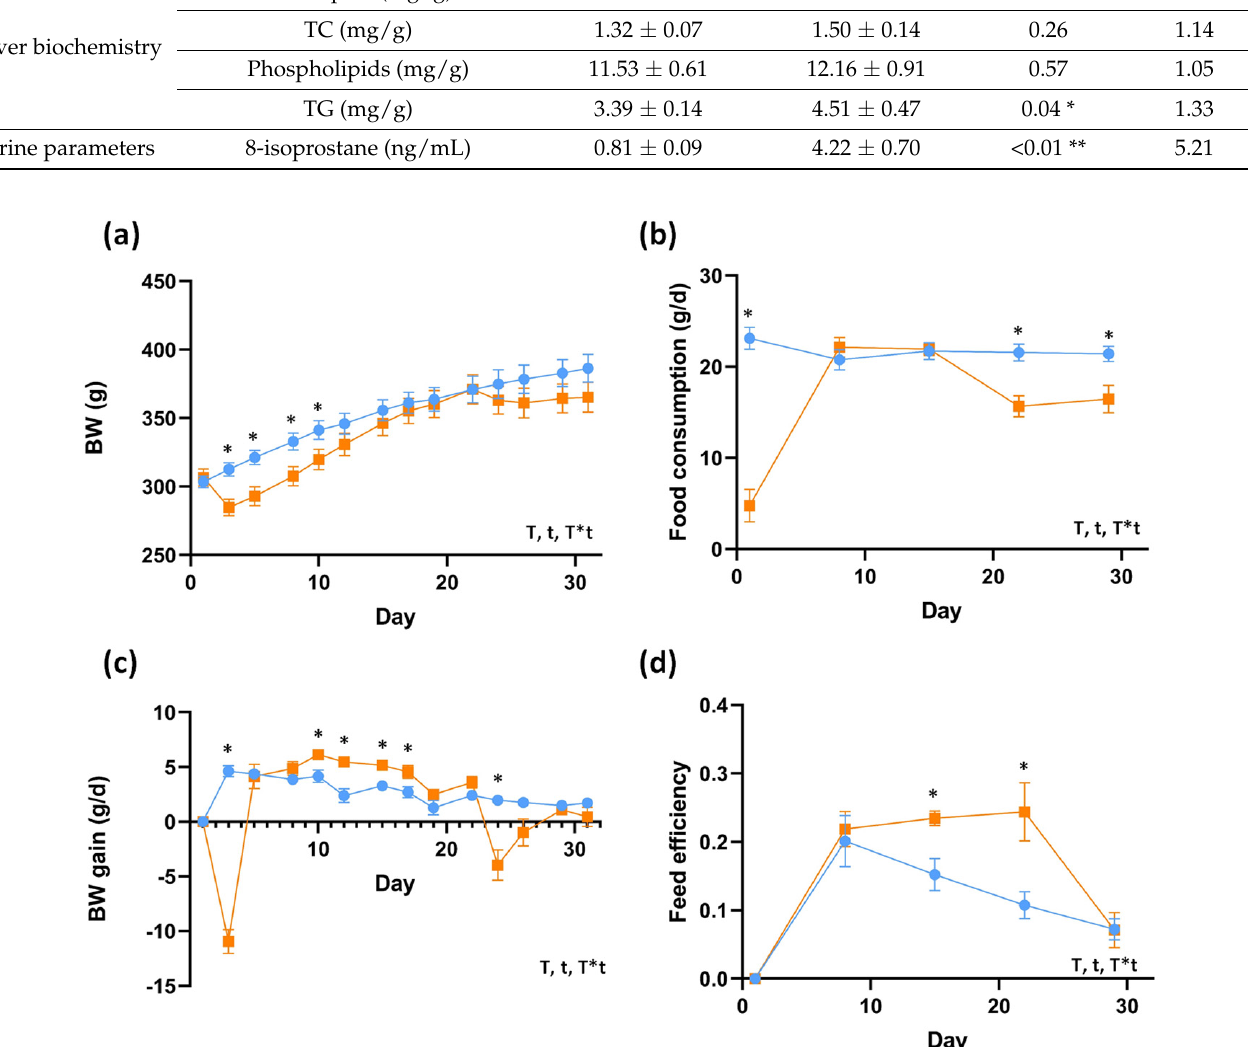
Figure 2. Body weight (BW) ( a ), BW gain ( b ), food consumption ( c ) and feed efficiency ( d ) of the LPS-induced inflammation model. Blue represents CON group and orange LPS group. Each point of represented data corresponds to the mean ± SEM ( n = 10 per group). * indicates significant differences using repeated-measures ANOVA followed by t -student test between CON and LPS group ( p < 0.05). T indicates treatment effect; t, indicates time effect; T*t interaction between treatment and time. Abbreviations: BW, body weight.